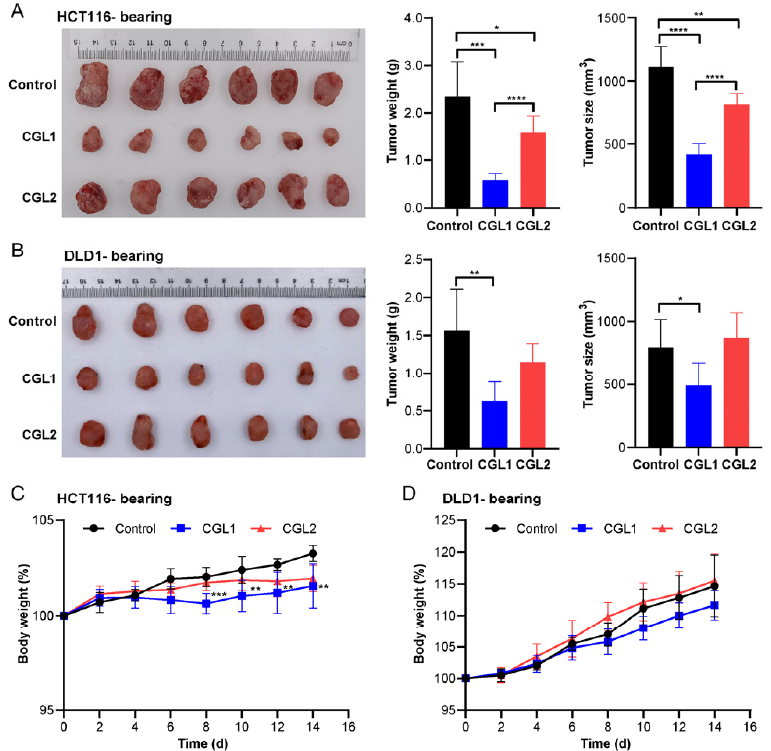
Figure 6. CGL1 exhibits significant anti-colorectal cancer effects in vivo. ( A , B ), Typical tumor photographs, tumor weights, and tumor sizes from HCT116-bearing ( A ) or DLD1-bearing ( B ) mice treated with CGL1 and CGL2 on day 14. ( C , D ), Curves of average body weights from HCT116-bearing ( C ) or DLD1-bearing ( D ) mice during CGL1 and CGL2 injection. The data were analyzed using a student’s t -test (* p < 0.05, ** p < 0.01, *** p < 0.001, **** p < 0.001). Control stands for HCT116-bearing or DLD1-bearing mice injected with PBS. Data show mean ± SD, n =